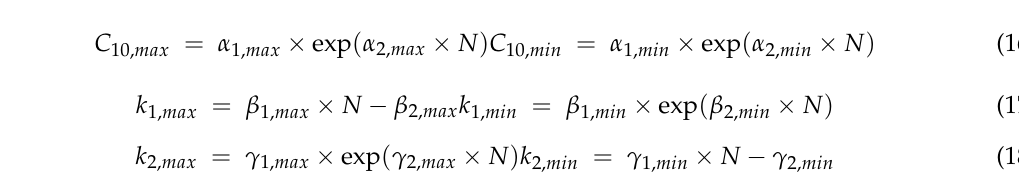
Table 1. Coefficients and R-squared in the correlation between values of material constants and